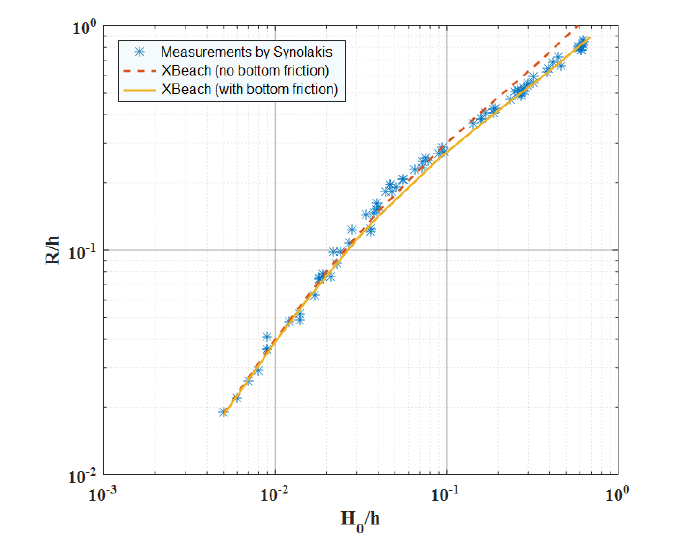
Figure 4. Dimensionless maximum runup height ( R / h ) of a solitary wave on a 1:19.85 beach as a function of the initial wave nonlinearity ( H 0 / h ) . Symbol: experimental data by Synolakis [26]. Dashed: numerical results by XBeach [20] with zero bottom friction. Solid: XBeach results with additional bottom friction using a Chézy coefficient C f = 75.